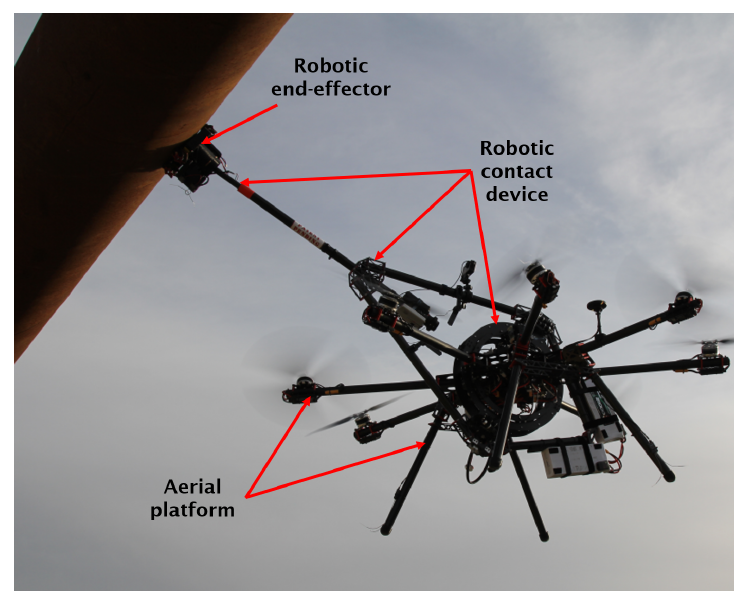
Figure 2. The AeroX robot in physical inspection of a pipe during a validation